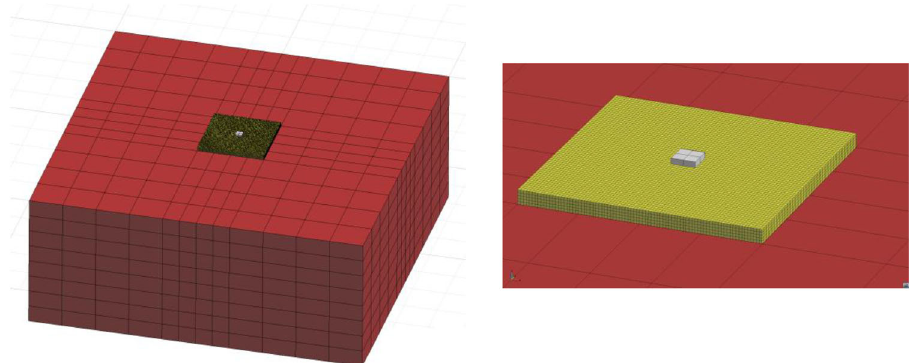
Fig. 12 3D Calculation model.